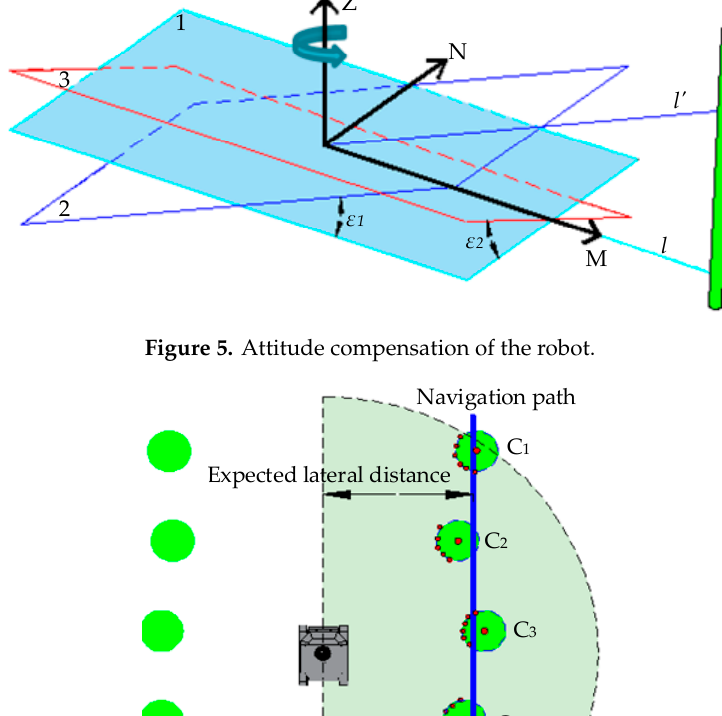
Figure 5. Attitude compensation of the robot.